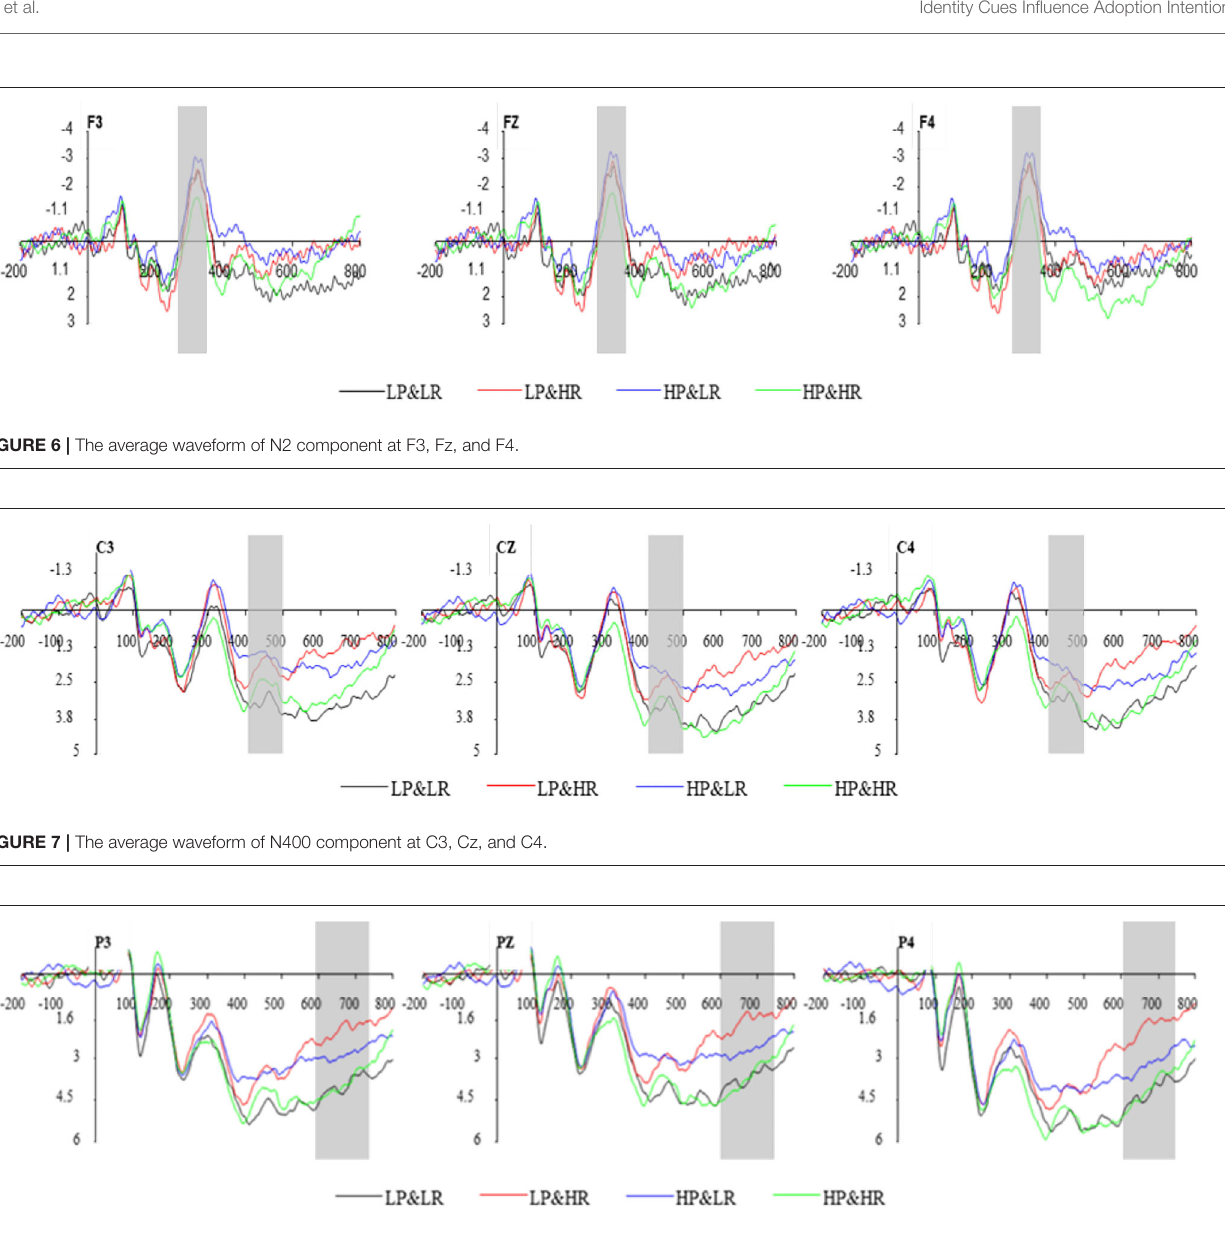
FIGURE 8 | The average waveform of LPP component at P3, Pz, and